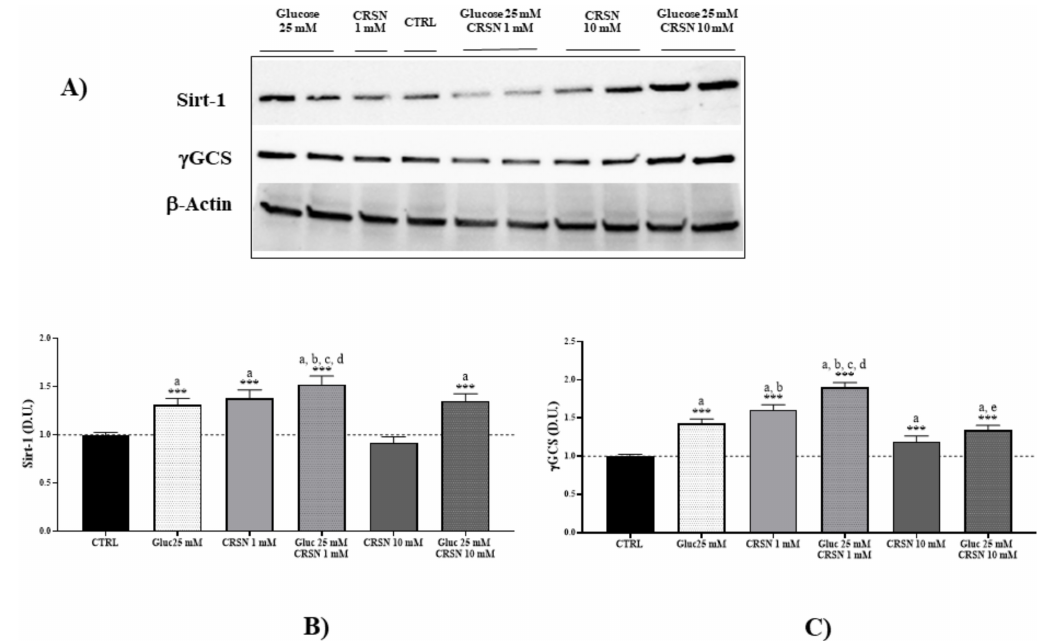
Figure 2. Cellular sirtuin-1 (Sirt-1) and gamma-glutamyl cysteine synthetase ( γ -GCS) protein concentrations (normalized to untreated cells) significantly increased in murine immortalized podocytes under glucose stress (25 mM; p = 1.4 × 10 − 3 and p = 5.5 × 10 − 7 , respectively) or under carnosine addition (1 mM; p = 1.0 × 10 − 3 and p = 4.4 × 10 − 8 , respectively). Co-incubation with carnosine (1 mM) and glucose (25 mM) induced further upregulation of Sirt-1 and γ -GCS proteins compared to single treatment ( p = 0.002 vs. glucose and p = 0.03 vs. carnosine for Sirt-1; p = 1.6 × 10 − 6 vs. glucose and p = 6.7 × 10 − 3 vs. carnosine for γ -GCS) or control ( p = 1.1 × 10 − 6 and p = 1.1 × 10 − 8 for Sirt-1 and γ -GCS, respectively), determined by western blotting ( A ) and quantified with an imaging software normalized to respective β -actin concentrations ( B , C ). Note: n = 5, a = significant increase vs. control, b = significant increase vs. glucose (25 mM), c = significant increase vs. carnosine (1 mM), d = significant increase vs. glucose (25 mM) + carnosine (10 mM), *** p <